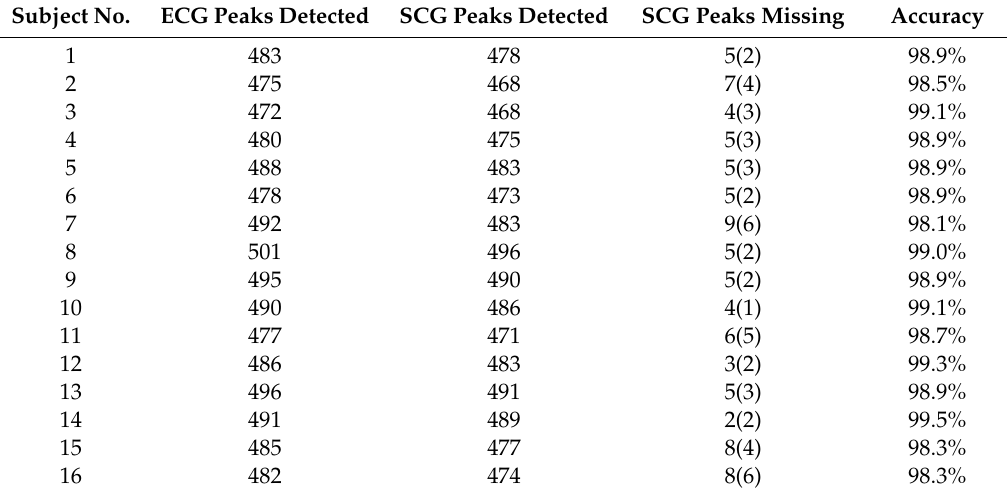
Table 1. Heartbeat detection